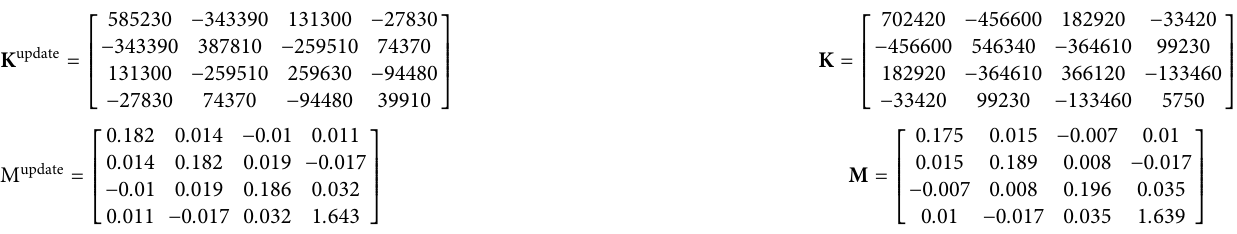
Table 4: Mass and stiffness matrices of the beam before and after updating based on frequency data.